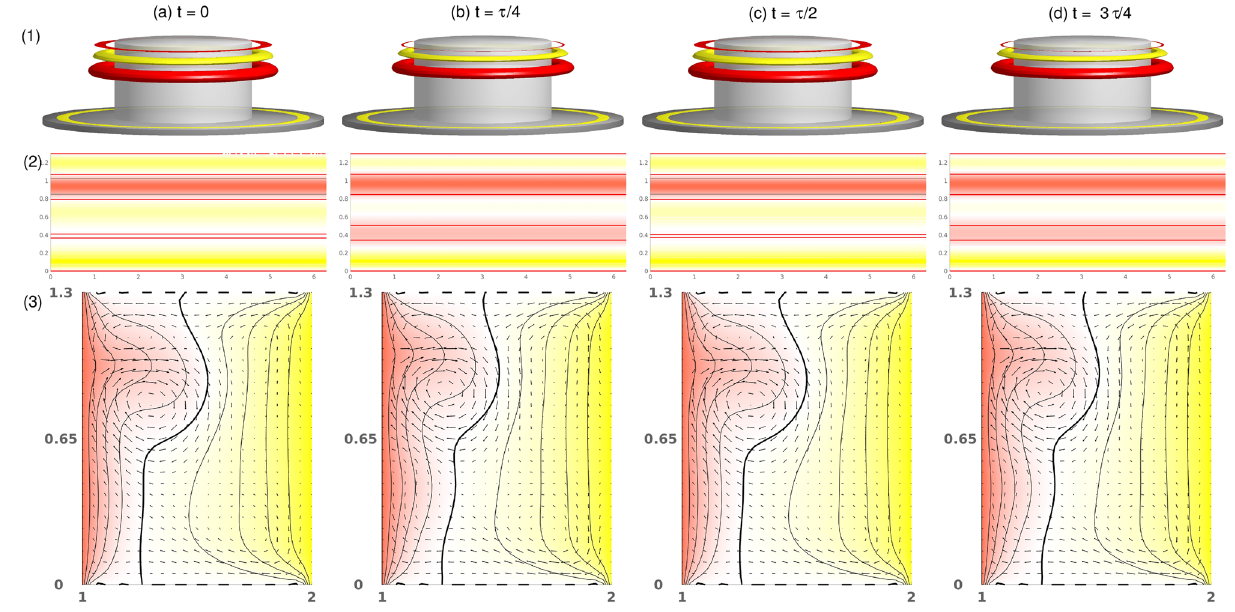
puls α 3.7 . One period, τ , at instants of time, t , is 1 , for = − 240 ); (2) Azimuthal velocity at cylinder mid- = ± 0 ) , = 0.194 . See also the ≈